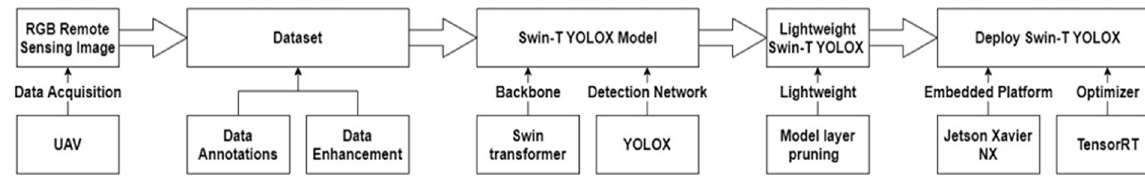
Figure 1. The overall flow chart of the